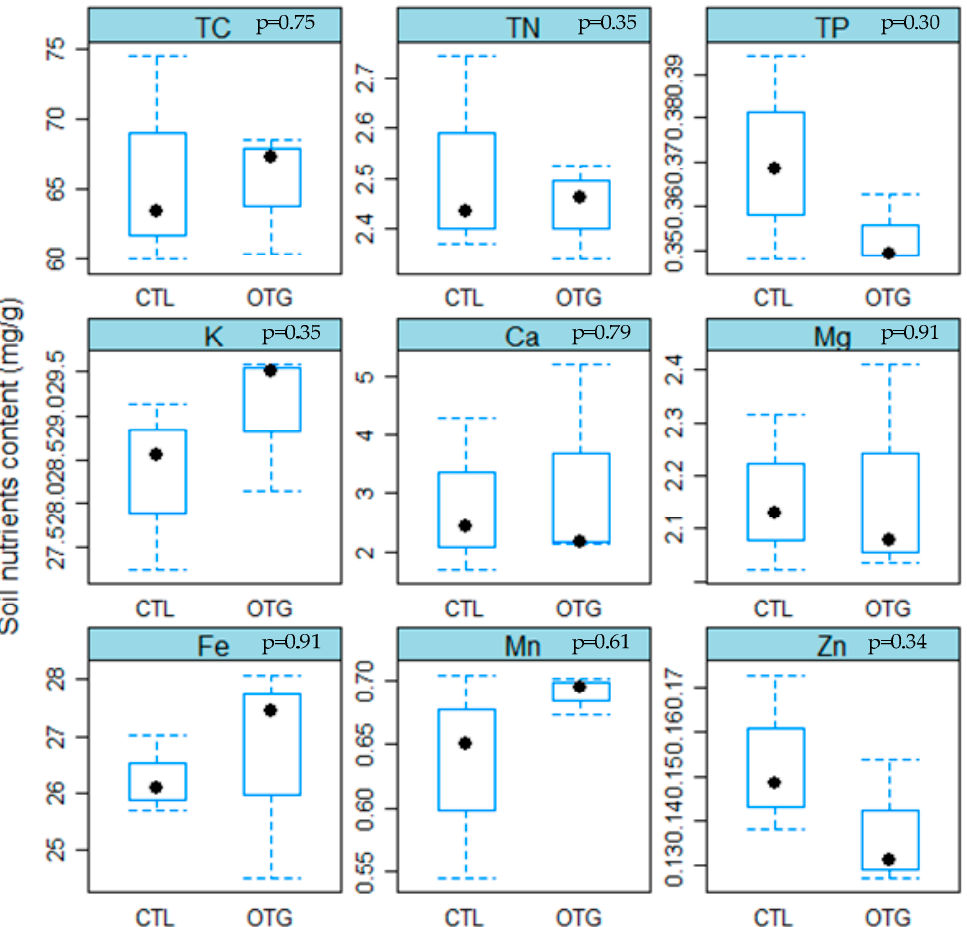
Figure 3. Soil nutrient contents (TC, TN, TP, K, Ca, Mg, Fe, Mn, and Zn) at the continuous treeline (CTL) and outposts of tree groups (OTG) sites on the north facing-slope of Changbai Mountain. The black points represent median values, the p values in panel titles show difference of variables between CTL and OTG analyzed by t-test. All the soil nutrients content showed no difference between CTL and OTG sites.